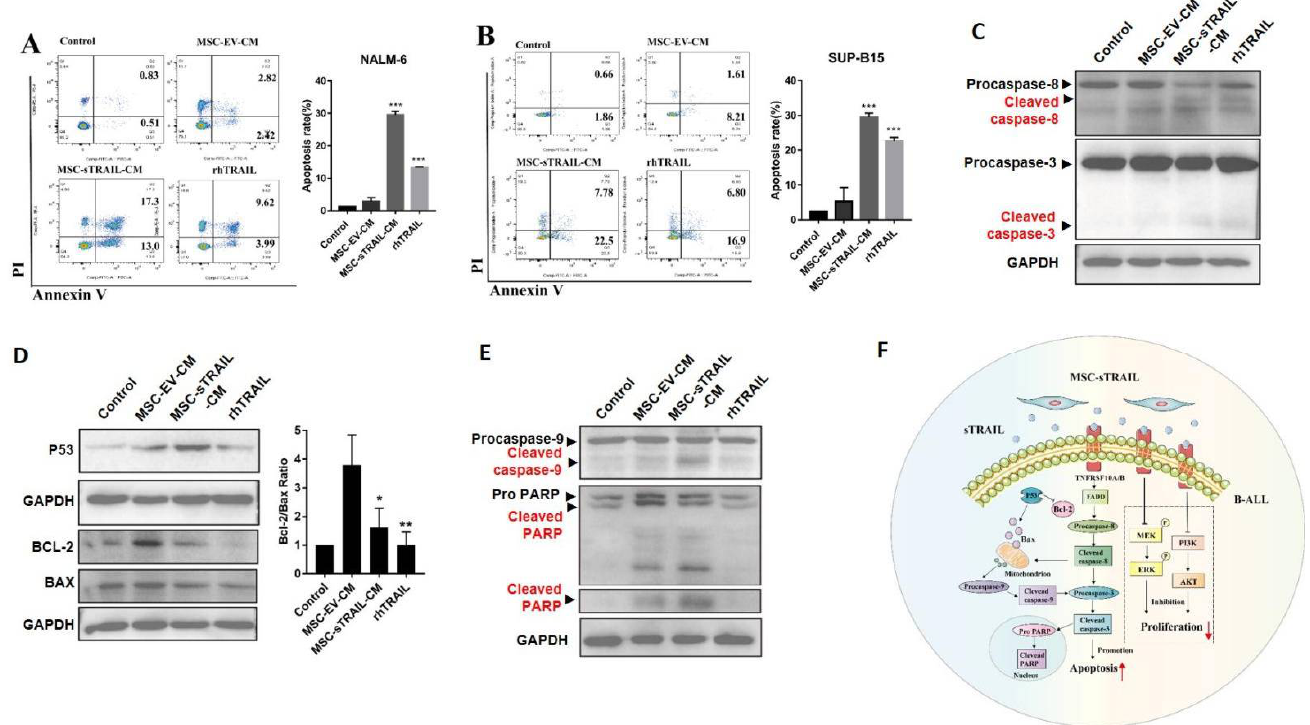
Figure 3. MSC-sTRAIL promotes apoptosis in B-ALL cell lines Nalm-6 and Sup-b15 cells. After treating Nalm-6 and Sup-b15 cells with MSC-EV-CM, MSC-sTRAIL-CM, or rhTRAIL for 72 h. ( A , B ) MSC-sTRAIL promotes the apoptosis of Nalm-6 and Sup-b15 cells. Nalm-6 cells were treated without (control group) or with MSC-EV-CM, MSC-sTRAIL-CM, or rhTRAIL for 48 h, then, ( C ) Protein levels of procaspase-8, cleaved caspase-8, procaspase3, and cleaved caspase-3 were investigated by western blotting, and GAPDH was used as inner control. ( D ) Protein levels of p53, Bcl-2, and Bax were investigated by western blotting, and GAPDH was used as inner control; the densitometry readings of each band were calculated by Image J software, then the ratio of Bcl-2/Bax were calculated and compared between each group. ( E ) Protein levels of procaspase-9, cleaved caspase-9, proPARP, and cleaved PARP were investigated by western blotting, and GAPDH was used as the inner control. ( F ) Summary diagram of the mechanism of how MSC-sTRAIL inhibits the proliferation and promotes apoptosis of B-ALL cells. ( n = three independent experiments per group; Student’s t test, *, p < 0.05, **, p < 0.01, ***, p < 0.001, MSC-sTRAIL-CM group, and rhTRAIL group compared with MSC-EV-CM group).